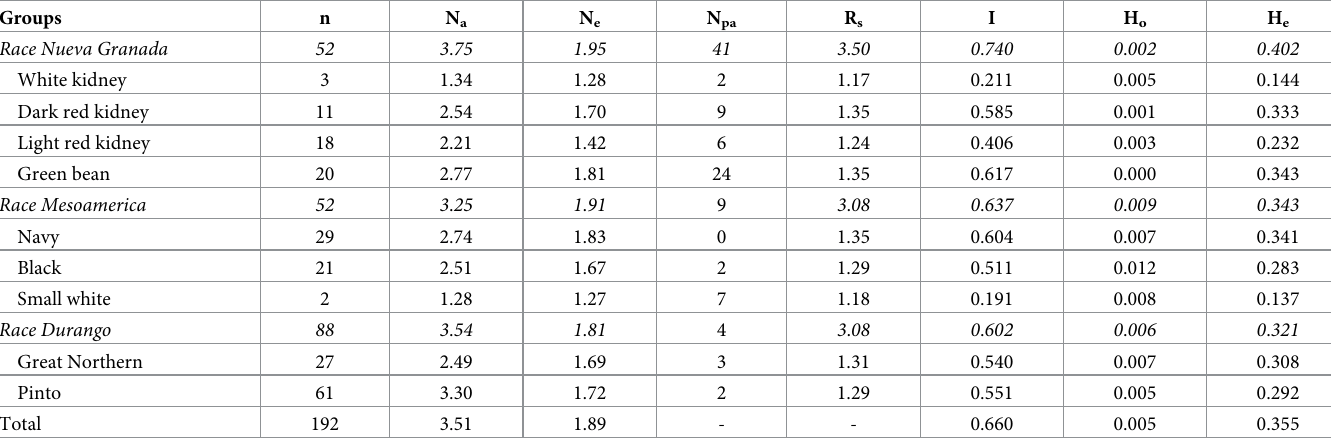
Table 1. Genetic diversity estimates computed for all the 58 SSR loci considering the nine commercial market classes defined according to the pedigree data. Groups